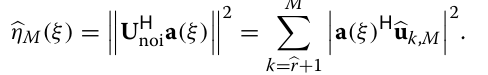
M ) associated with the example ASF in (cid:31) y ( (cid:31)